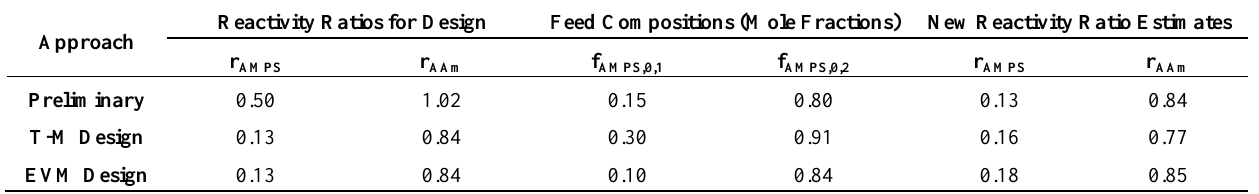
Table 2. Design of experiments and reactivity ratio estimates for AMPS/AAm.